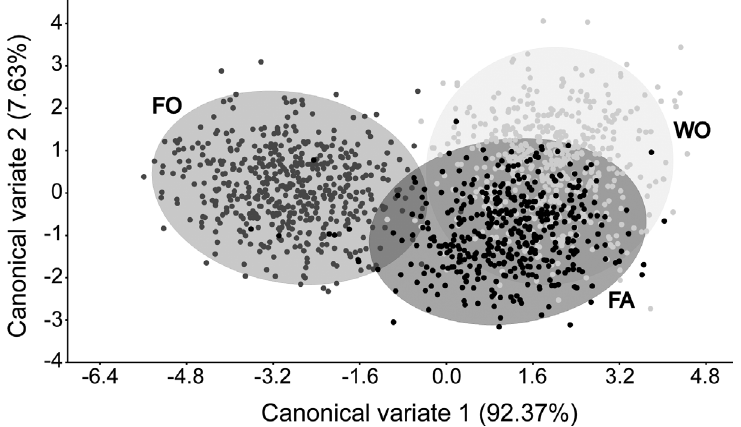
Fig. 3. Canonical variate ordination plot of sampled origins with 95% con - fidence ellipses of the scatter data points based on Procrustes distances. Farm-associated (FA) specimens are represented by black, farmed (FO) by dark grey and wild (WO) by light grey dots